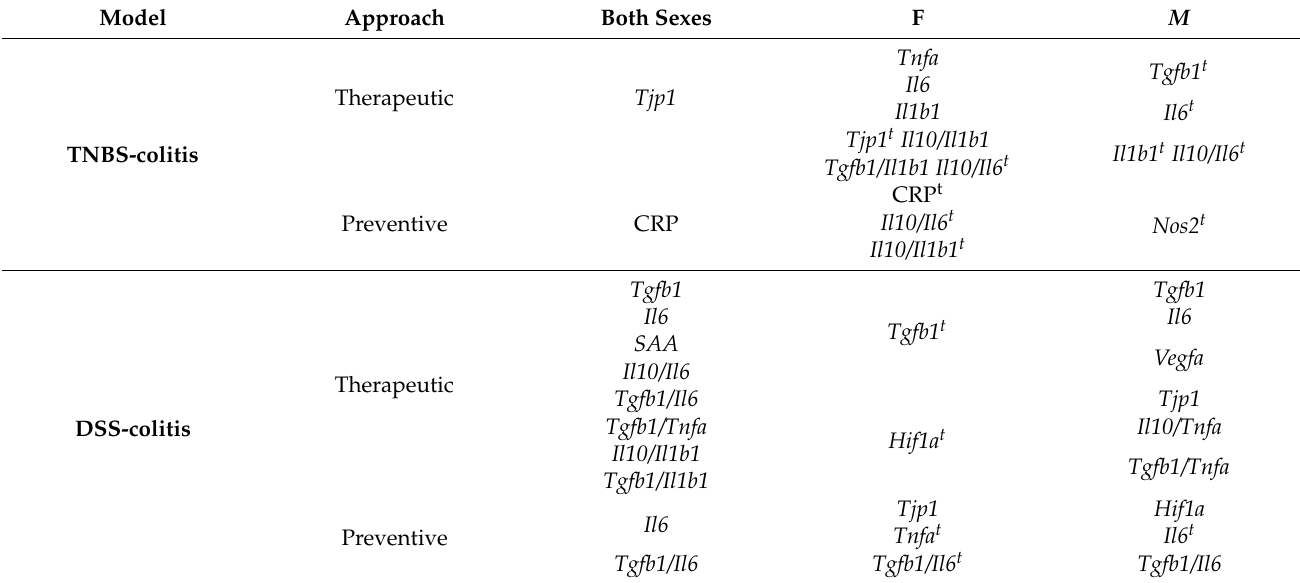
Table 4. Proposed remarkable mRNA mucosal and plasmatic APPs inflammatory and reparation markers with a moderate-high correlation with ROS detection using bioluminescence stratified by model, approach, and